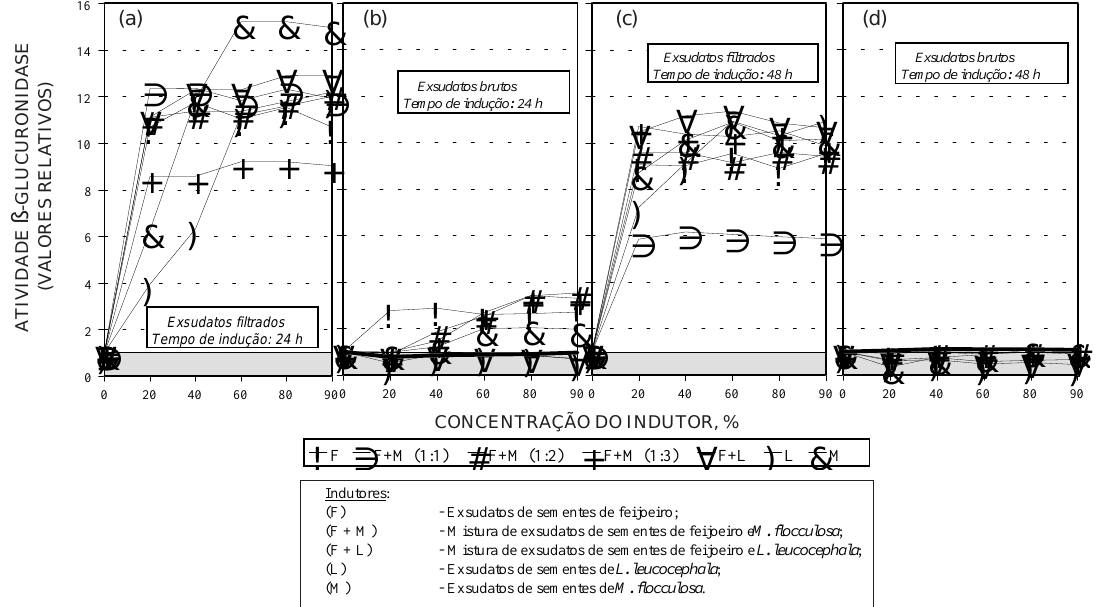
Figura 4. Atividade da enzima ß-glucuronidase, resultante da indução dos genes nod da estirpe CNPAF 512 (pGUS 32) pela presença de exsudatos de sementes filtrados (a, c) e brutos (b, d), em dois tempos de indução distintos (24 e 48 h). Valores relativos aos controles (culturas de bactérias na ausência de indutores - exsudatos de sementes). Os valores referentes aos controles são iguais a 1,0.